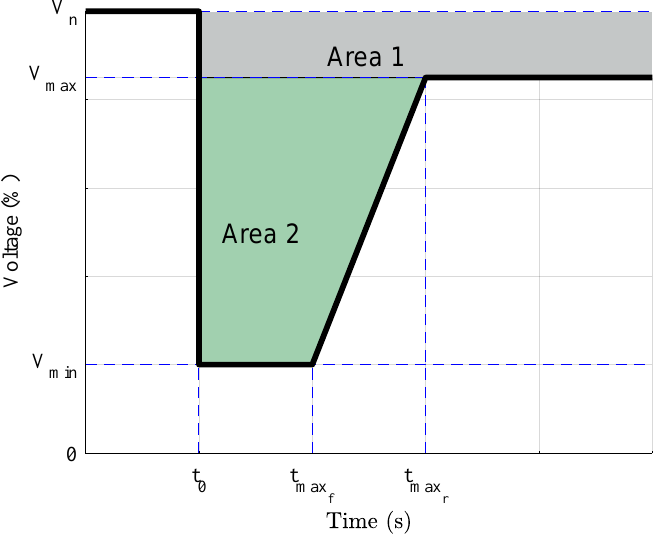
Figure 4. Generalized limits for LVRT requirements.